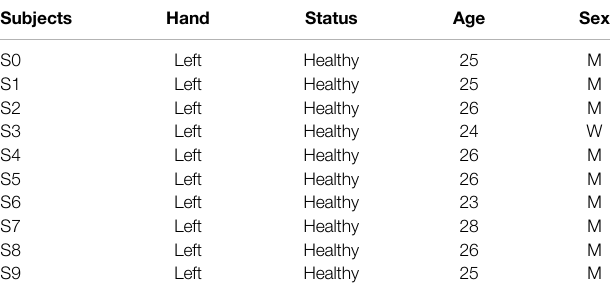
TABLE 1 | Demographic information the subjects.